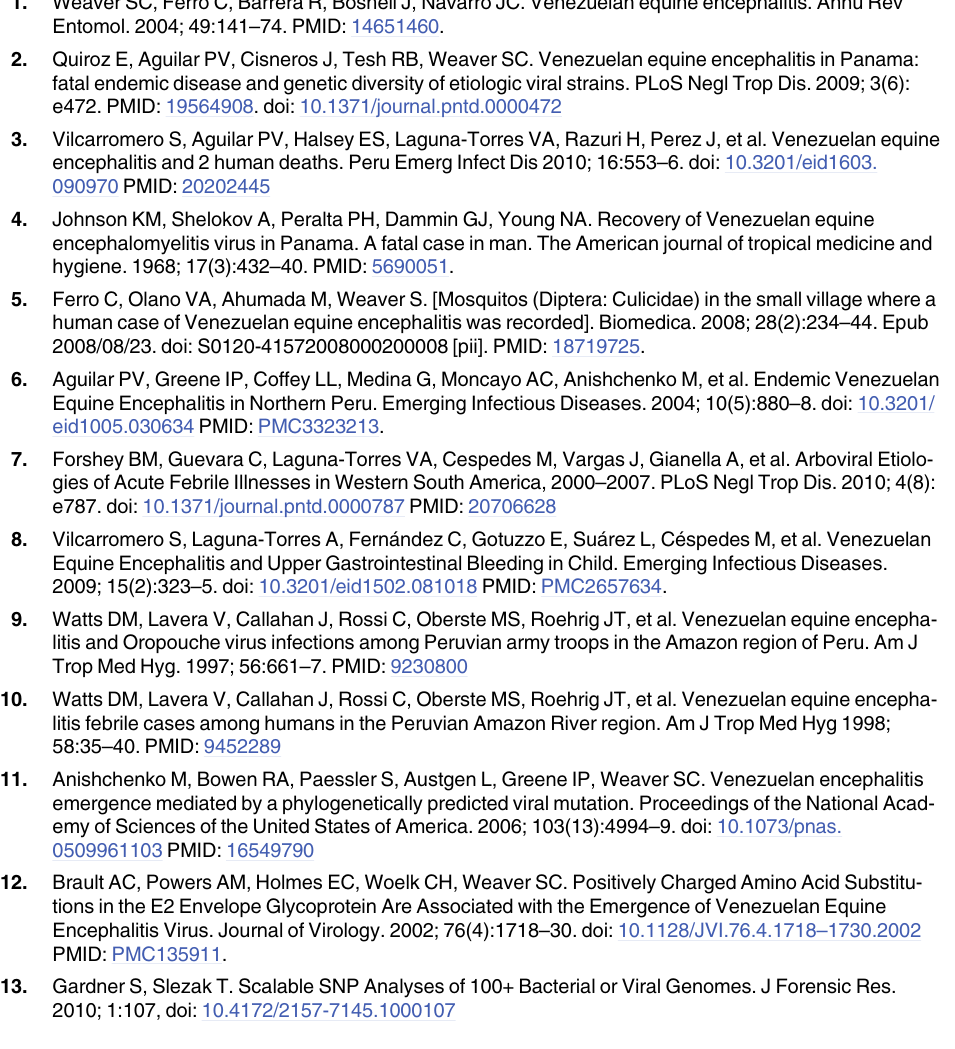
S4 Table. Comparison of genotypes for VEEV on tissue from TC-83 infected